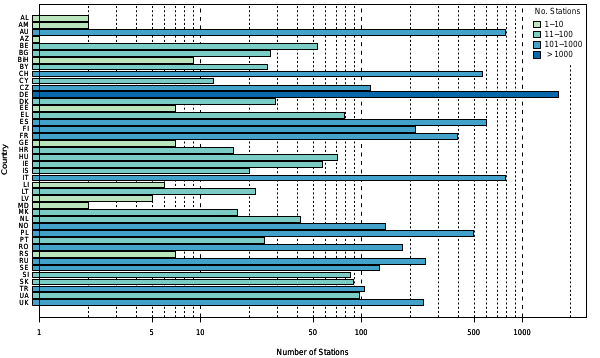
Figure 2. Number of stations per